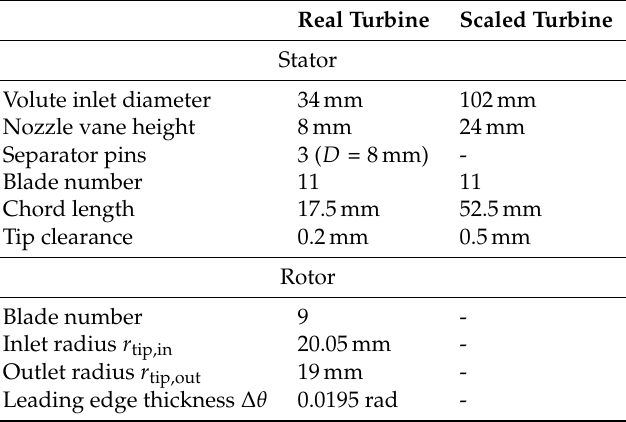
Table 1. Geometry